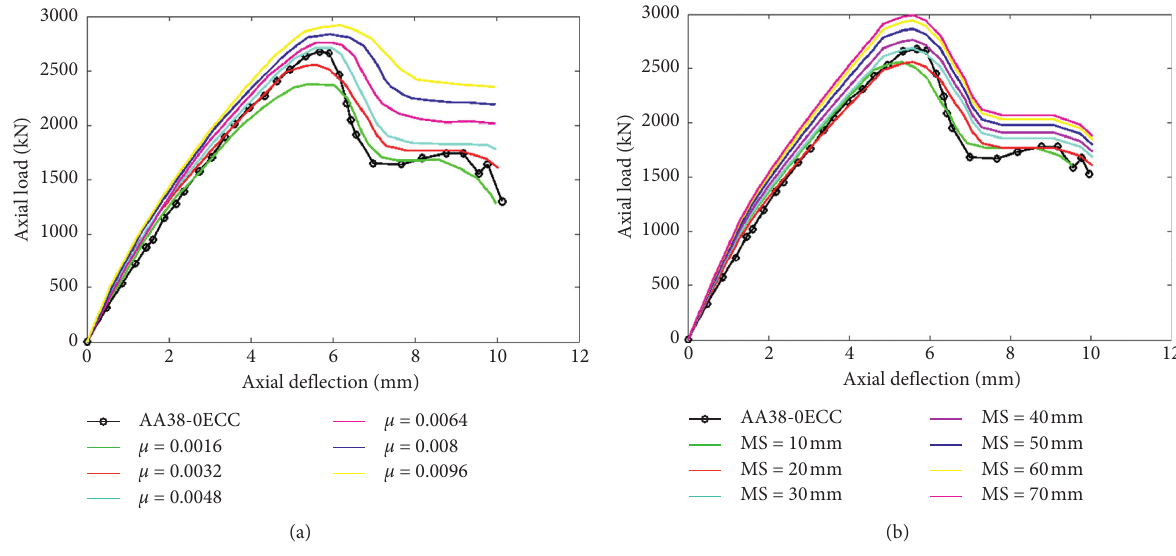
Figure 7: Effect of (a) viscosity parameter ( μ ) and (b) mesh size (MS) on the load-deflection performance of the control